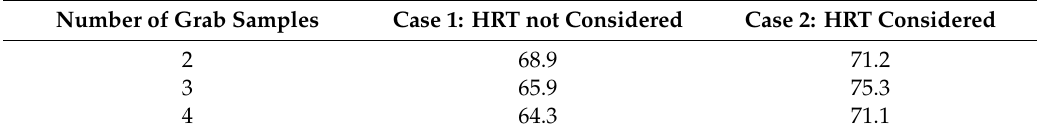
Table 9. Removal e ffi ciency of RV_Sub in the case of grab samples in di ff erent scenarios. Table 9. Removal efficiency of RV_Sub in the case of grab samples in different scenarios. Number of Grab